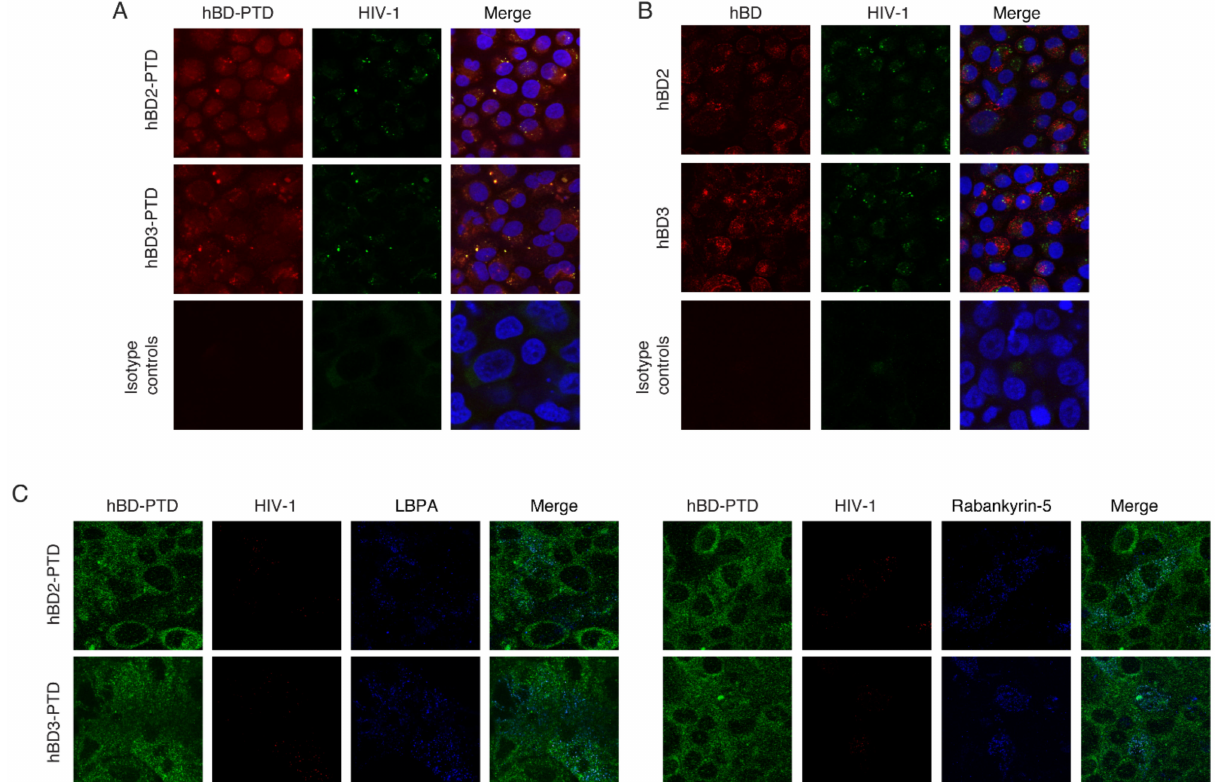
Figure 4. The PTD signal delivered hBD-2 PTD and hBD-3 PTD into vesicles containing HIV-1. ( A , B ) Polarized tonsil epithelial cells were exposed to HIV-1 SF33 (20 ng/mL) and after 48 h, hBD-2 or -3 (50 µ g/mL) was added with ( A ) or without ( B ) PTD for 1 h. Cells were then coimmunostained for hBD-2 or -3 (both red) and with HIV-1 p24 (green). Cells were analyzed by confocal microscopy. In merged panels, yellow shows colocalization of hBDs with HIV-1. ( C ) Cells were also coimmunostained for hBD-2 or -3 (green), p24 (red), and LBPA or rabankyrin-5 (blue), which are markers for MVB and vacuoles, respectively. White/pink in merged panels shows colocalization of hBDs, HIV-1, and markers of MVB or vacuoles. ( A , B ) Nuclei were counterstained with DAPI (blue). ( A through C ) Magnification: × 630. Similar data were obtained in three independent